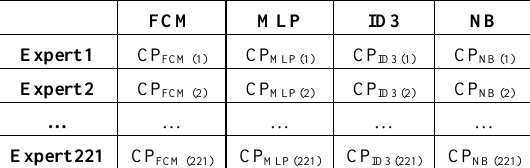
Table 1. Data organisation for processing. FCM